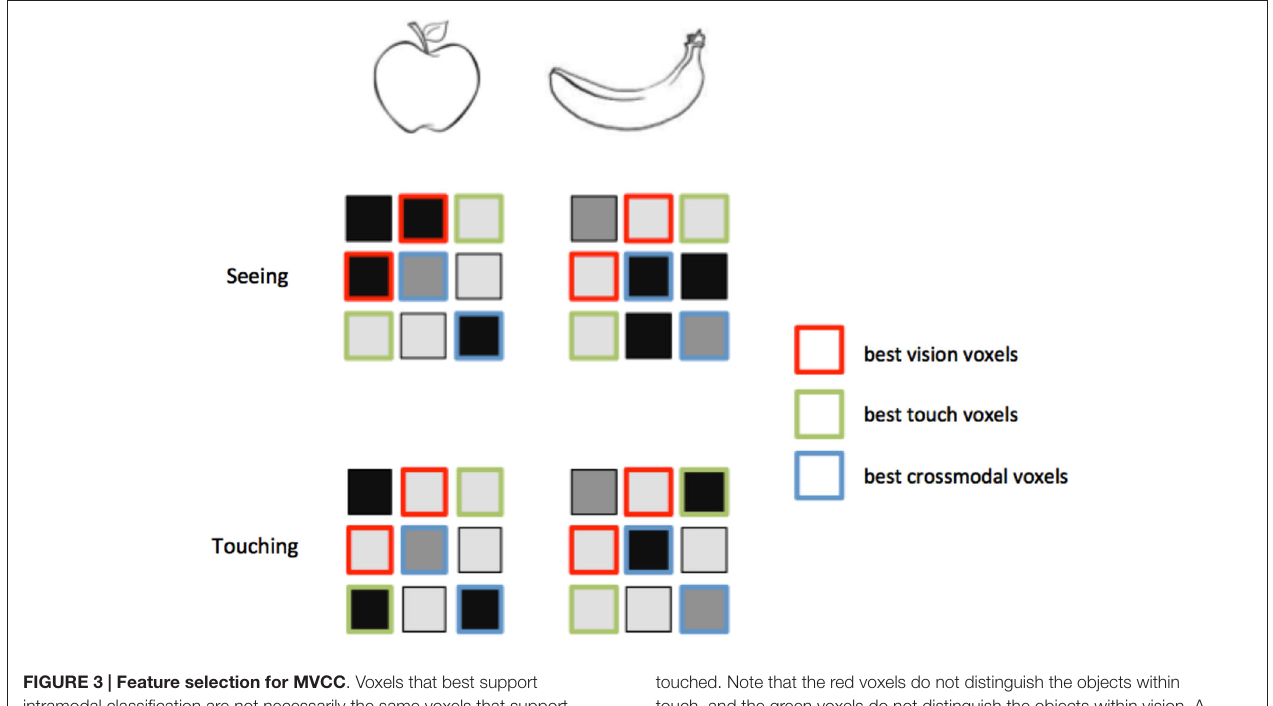
FIGURE 3 | Feature selection for MVCC . Voxels that best support intramodal classification are not necessarily the same voxels that support crossmodal classification. Again consider an experiment in which two objects, an apple and a banana, are seen and touched. In these hypothetical activity patterns, the voxels outlined in red distinguish best between the objects when they are seen. However, a different set of voxels, outlined in green, provide the best classification when the objects are